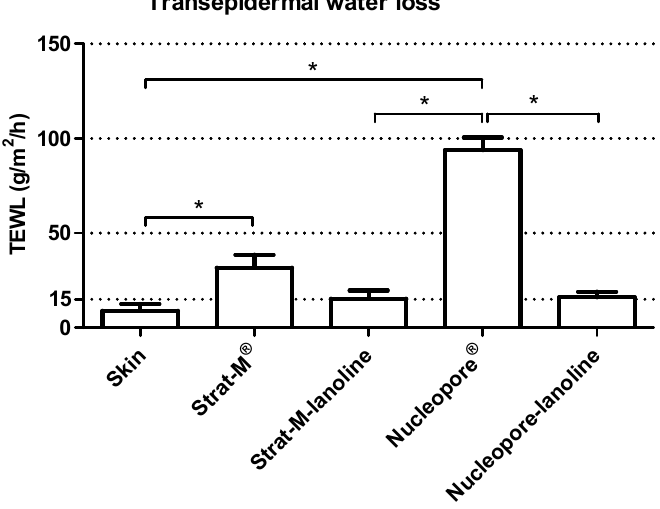
Figure 1. Transepidermal water loss (TEWL) measured on skin, Strat-M ® , Strat-M-lanolin, Nucleopore ® and Nucleopore-lanolin. * indicates a p -value ≤ 0.1 from the Kruskal–Wallis test. A low standard deviation was obtained in all the different membranes, including the